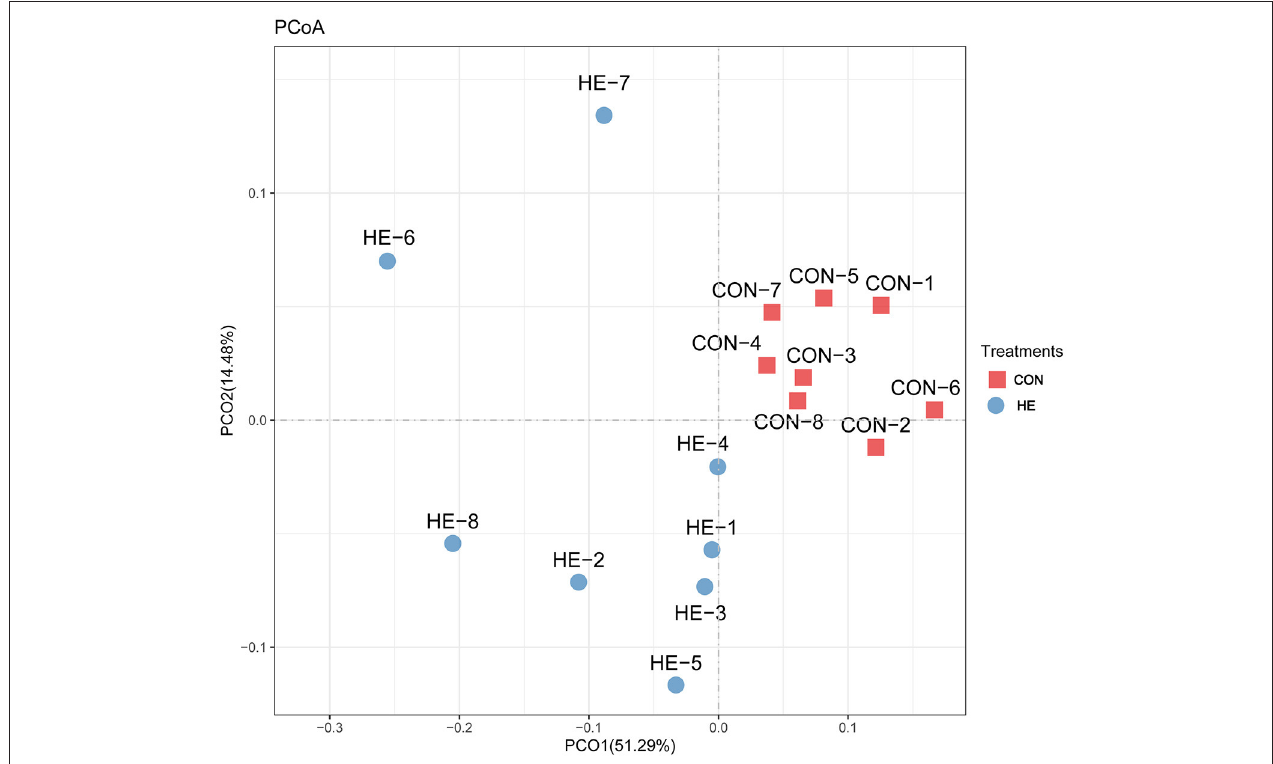
FIGURE 2 | Principal coordinate analysis (PCoA) on community structures of the cecal microbiota after honeycomb flavonoids (0.5% supplementation) treatment. CON, control diet; HF, honeycomb flavonoids supplement treatment.